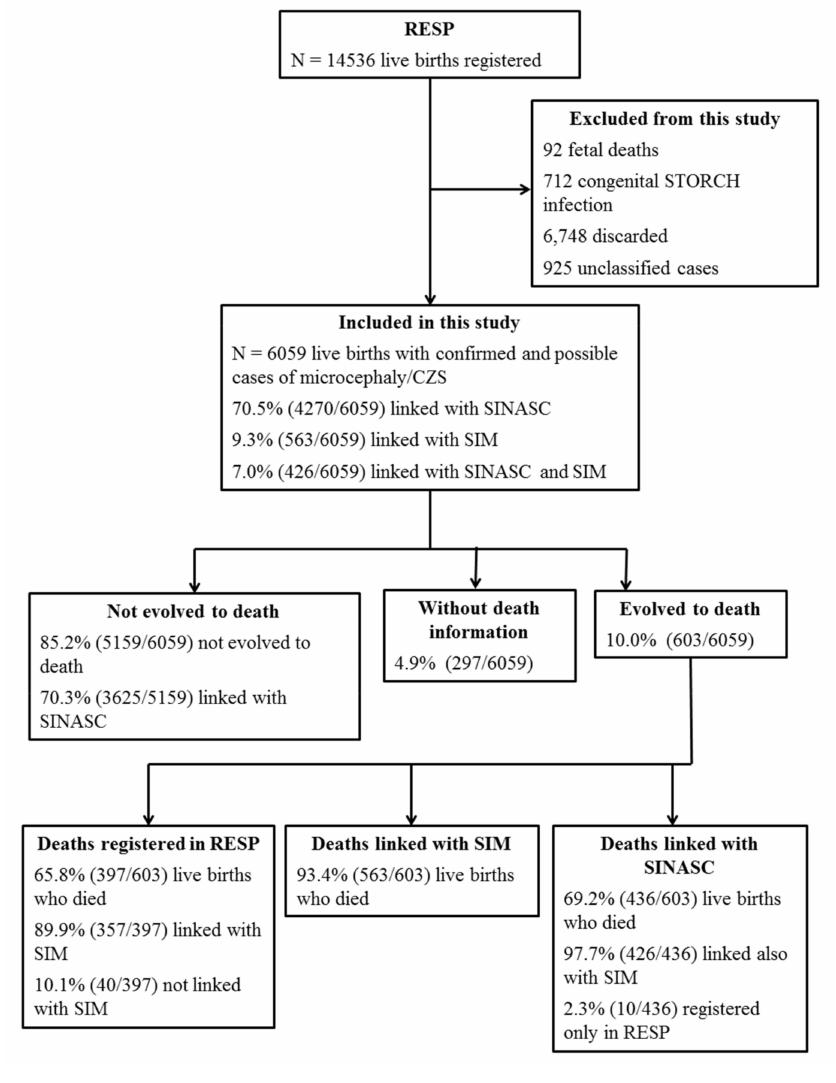
Figure 1. Flowchart of the selection process of notified cases and deaths by microcephaly / congenital Zika syndrome for the study of the case fatality rate related to this syndrome. Brazil, 2015 to